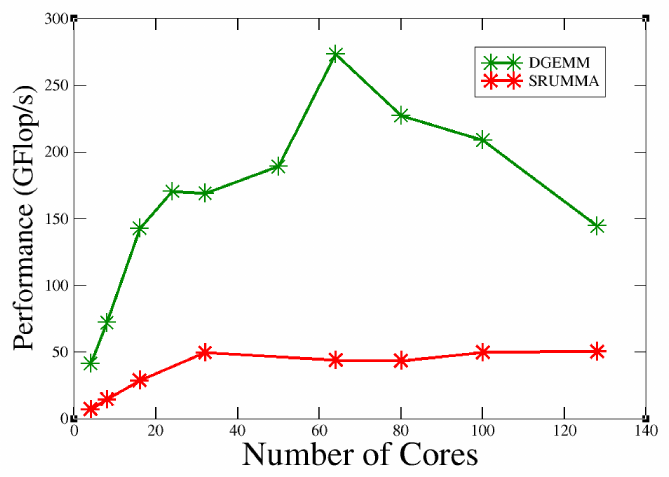
Figure 17. Performance of SRUMMA vs.